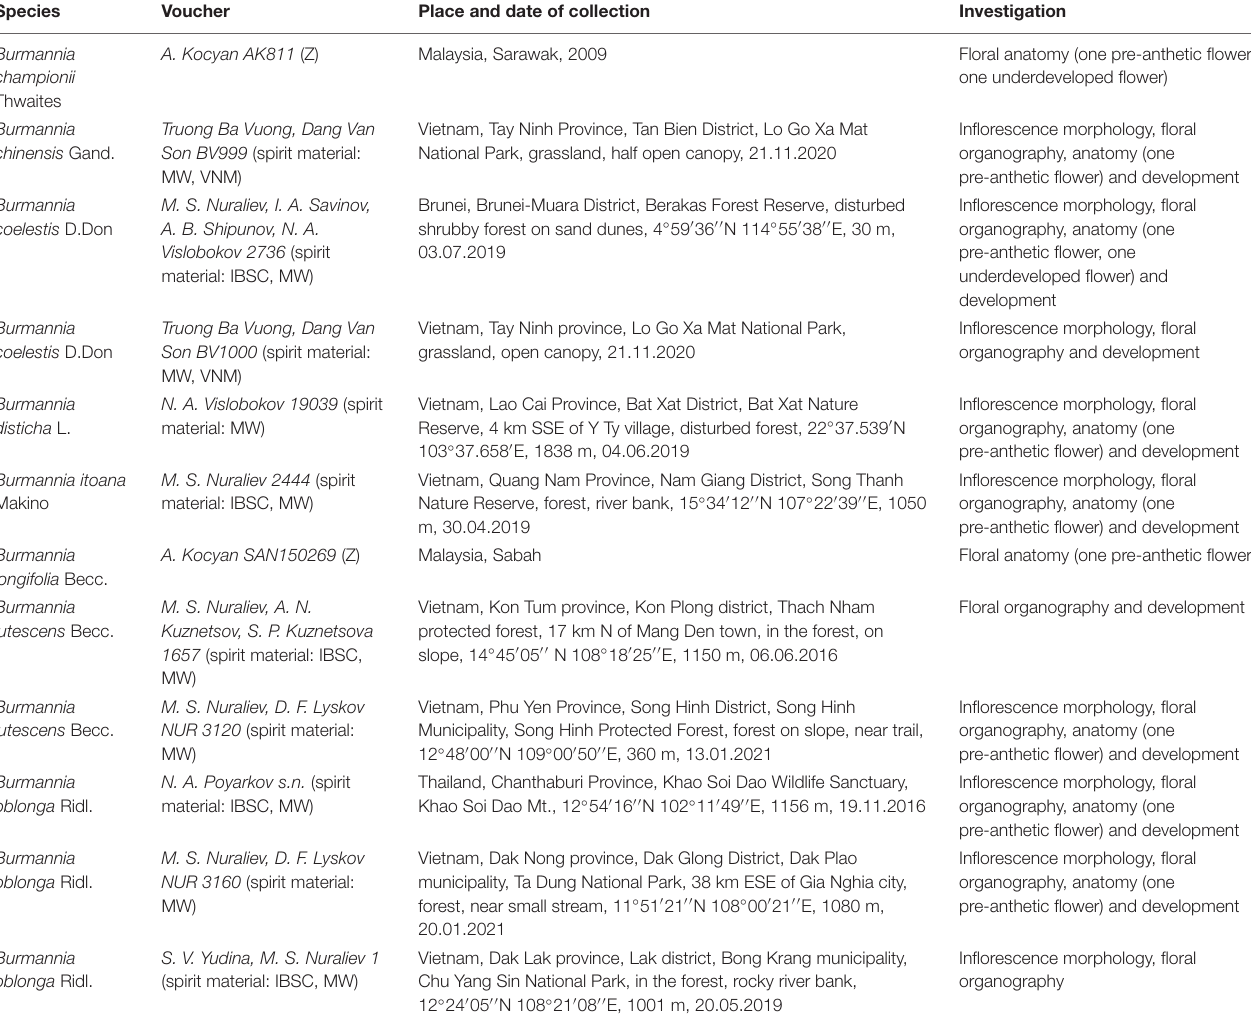
TABLE 1 | Voucher specimens for the examined material, and the investigations